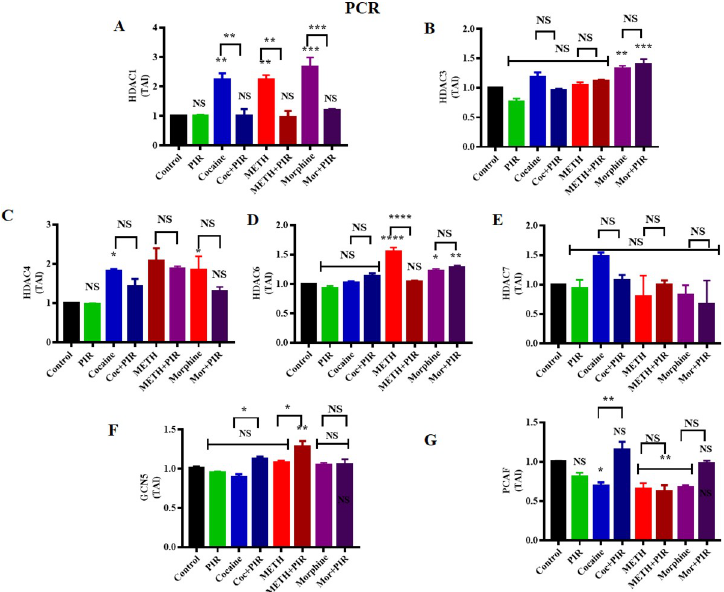
Fig 5. Effects of the psychostimulants cocaine, METH and morphine on HDAC and HAT gene expression in human primary astrocytes. Human primary astrocytes were exposed to cocaine (1 μ M), METH (10 μ M) and morphine (5 μ M) either alone or in combination with piracetam (10 μ M) for 24 h. Controls were maintained in drug- free medium (without drug exposure). (A) HDAC1, (B) HDAC3, (C) HDAC4, (D) HDAC6 and (E) HDAC7 (F) GCN5 (G) PCAF mRNA expression levels in astrocytes determined by qRT-PCR analysis using the housekeeping gene β -actin as a loading control. Two-way ANOVA analysis performed to compare the groups between cocaine Vs cocaine + piracetam, METH Vs METH + piracetam and morphine Vs morphine + piracetam. The data are expressed as the mean ± standard error mean of the transcript accumulation index (TAI) of three independent experiments. N = 3. ���� P < 0.0001, ��� P < 0.001, �� P < 0.01, � P < 0.05, NS—nonsignificant.